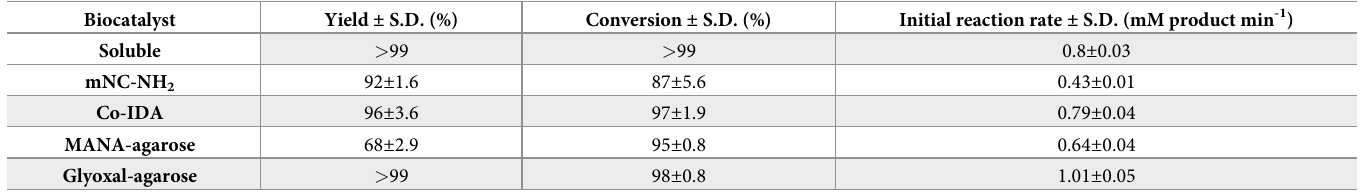
Table 2. Reaction yield, conversion and initial reaction rate of pre-D-fagomine synthesis catalyzed by FSA. Reactions conditions: 1 U mL -1 , 10 mL reaction volume � , 30 mM β -CHO, 45 mM DHA and 50 mM HEPES buffer, pH 8.0, 25˚C, orbital stirring. Biocatalyst